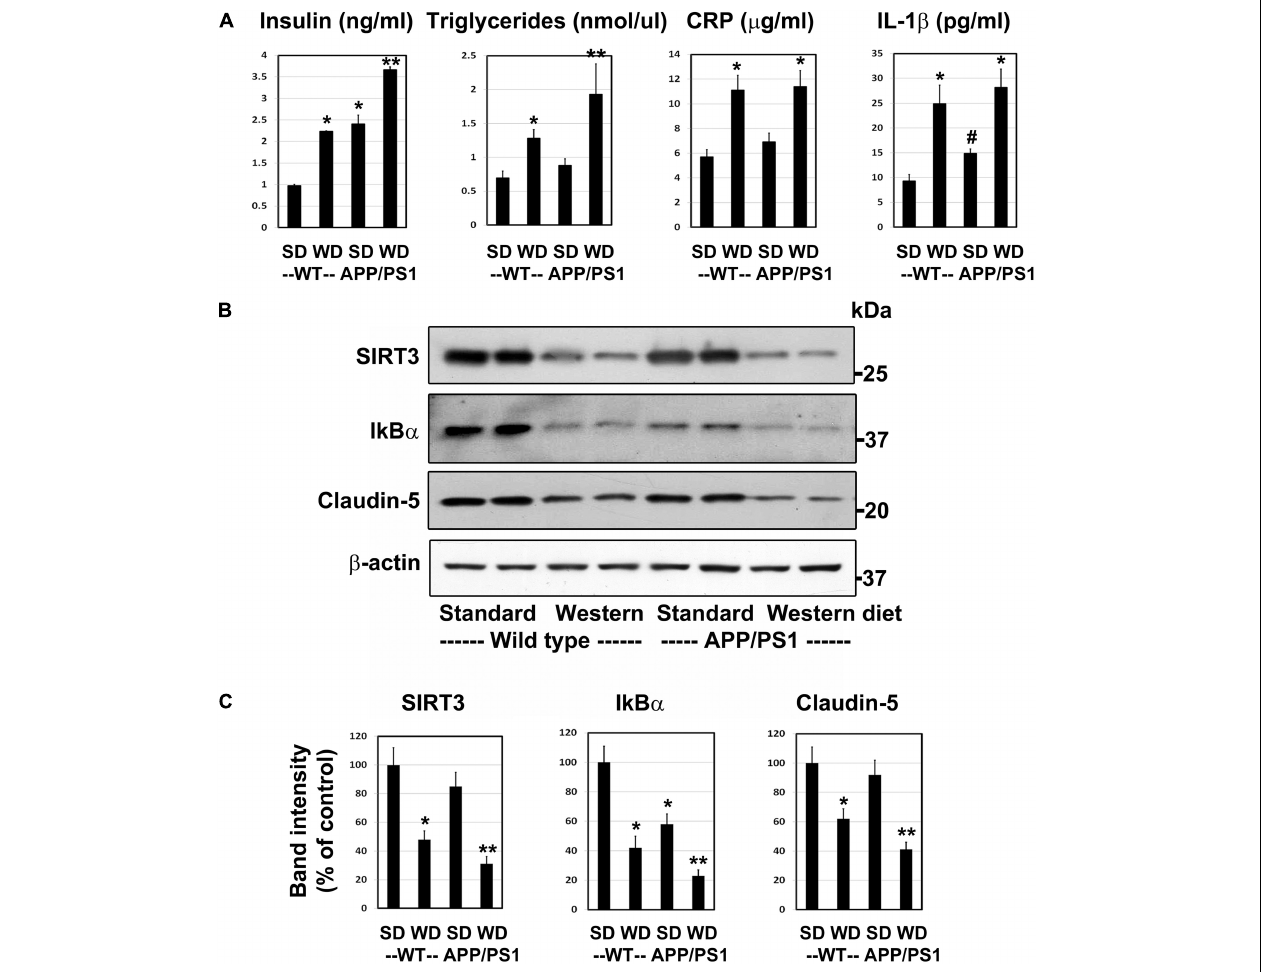
FIGURE 1 | Western diet induces insulin resistance and neuroinflammation and reduces the BBB integrity in APP/PS1 mice. (A) 6 weeks-old Wild type (WT) and APP/PS1 male mice were fed on standard diet (SD) or energy-rich western diet (WD) for 7 months. Plasma levels of insulin, CRP and IL-1 β were assayed by ELISA. Plasma triglycerides levels were determined calorimetrically using assay kit. All assays were performed following the manufactures’ protocol. (B) Mouse cortical samples from the four groups of mice were collected for the Western blot analysis of SIRT3, IkB α and claudin-5. The blots were re-probed for β -actin. (C) The band intensities were determined by scanning, corrected for β -actin levels, and expressed as percent of control. Data are expressed as mean of ± SE ( n = 6) for each group. # , P < 0.05; *, P < 0.01; **, P < 0.001 vs WT mice on standard